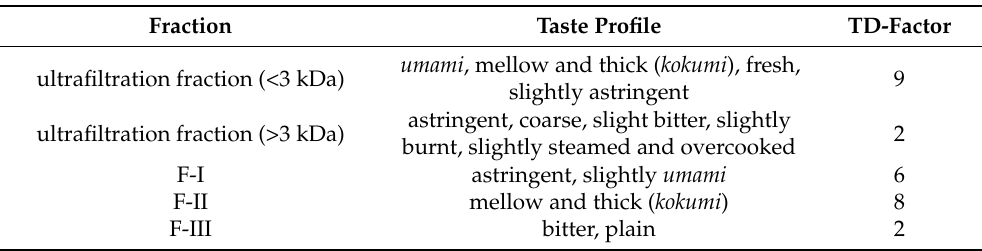
Table 1. Sensory evaluation of ultrafiltration and gel filtration fractions of kokumi-flavored green tea samples (1:50 Huiming green tea). Fraction Taste Profile TD-Factor umami , mellow and thick ( kokumi ), fresh, ultrafiltration fraction (<3 kDa) 9 slightly astringent astringent, coarse, slight bitter, slightly ultrafiltration fraction (>3 kDa) 2 burnt, slightly steamed and overcooked F-I astringent, slightly umami 6 F-II mellow and thick ( kokumi ) 8 F-III bitter, plain